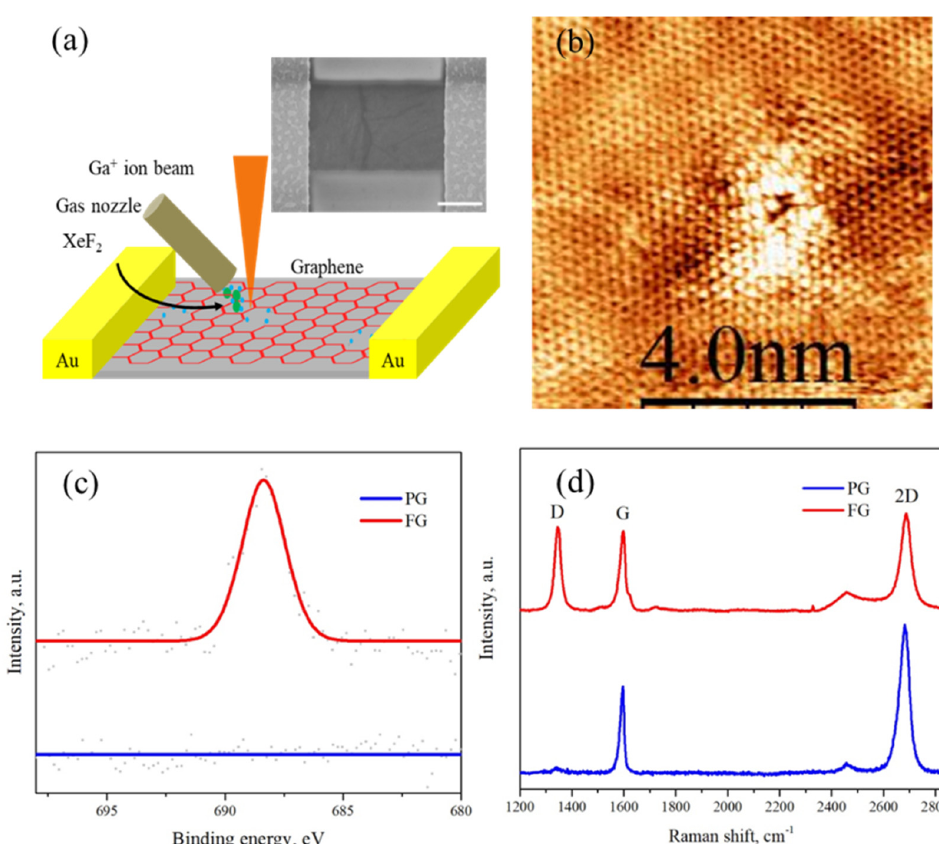
Figure 1. ( a ) Schematic diagram of the ion beam fluorination process on graphene sensors with two terminals. The scanning electron microscopy image of the device with scale bar of 1 µm is inserted. ( b ) Scanning tunneling microscopy image of FG. ( c ) X-ray photoelectron spectroscopy spectra of F1s peaks of PG and FG. ( d ) Raman spectra of PG and FG.